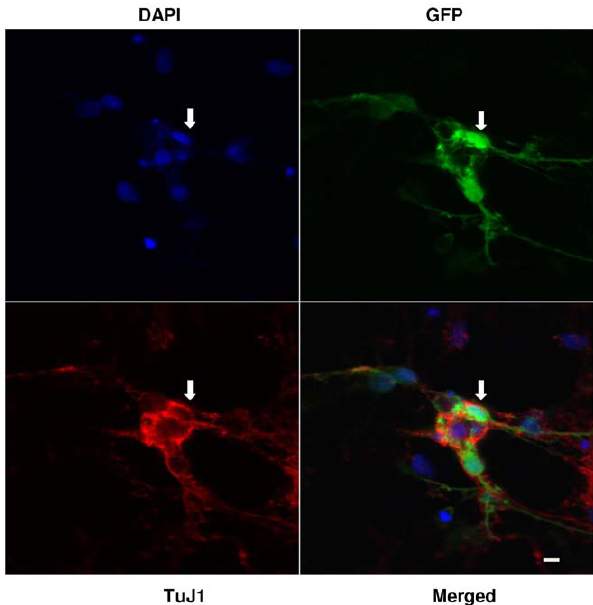
Figure 10. Transduction of lentiviral vectors into rat cerebral cortical neurons. Cortical neurons were cultured from rat embryonic brains at day 18 for seven days in vitro and then exposed to 9 6 10 5 lentiviral vector particles, comparable to the highest MOI used for gammaretroviral transduction. Five days later, the cells were fixed and immunostained with anti-GFP and TuJ1 antibodies, followed by DAPI staining. The cells were photographed with a laser scanning confocal microscope at 63 6 . Arrows indicate GFP-positive, TuJ1 positive cells. Scale bars=3 m m.